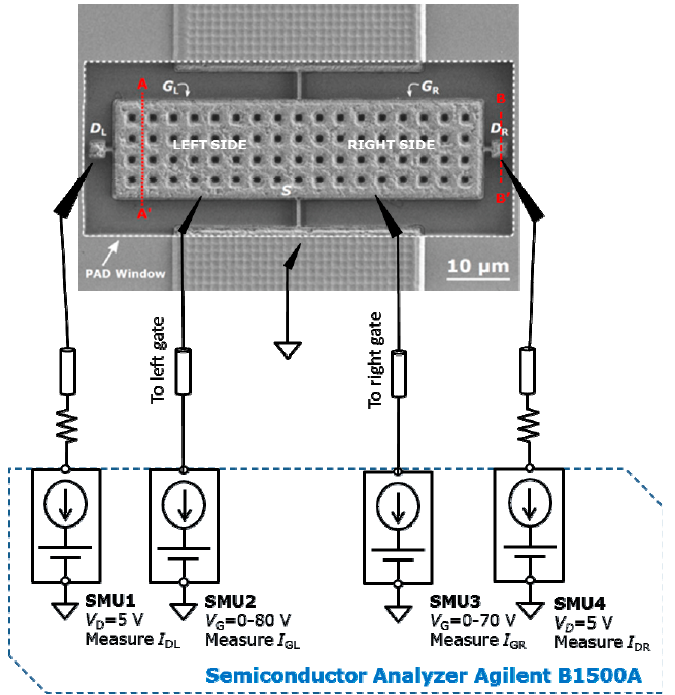
Figure 4. Electrical set-up for the current voltage ( I-V ) switching characteristics of the five-terminal relay. Four high-resolution source measure units (SMU) are used: the source electrode (relay structure) is grounded, drain electrodes (left and right) are fixed to a VD = 5 V, gate electrodes (left and right) are swept up and down from 0 to a voltage gate V G voltage higher than the pull-in voltage, V PI . Note that gates and drains are underneath the relay structure and are not visible in the image.